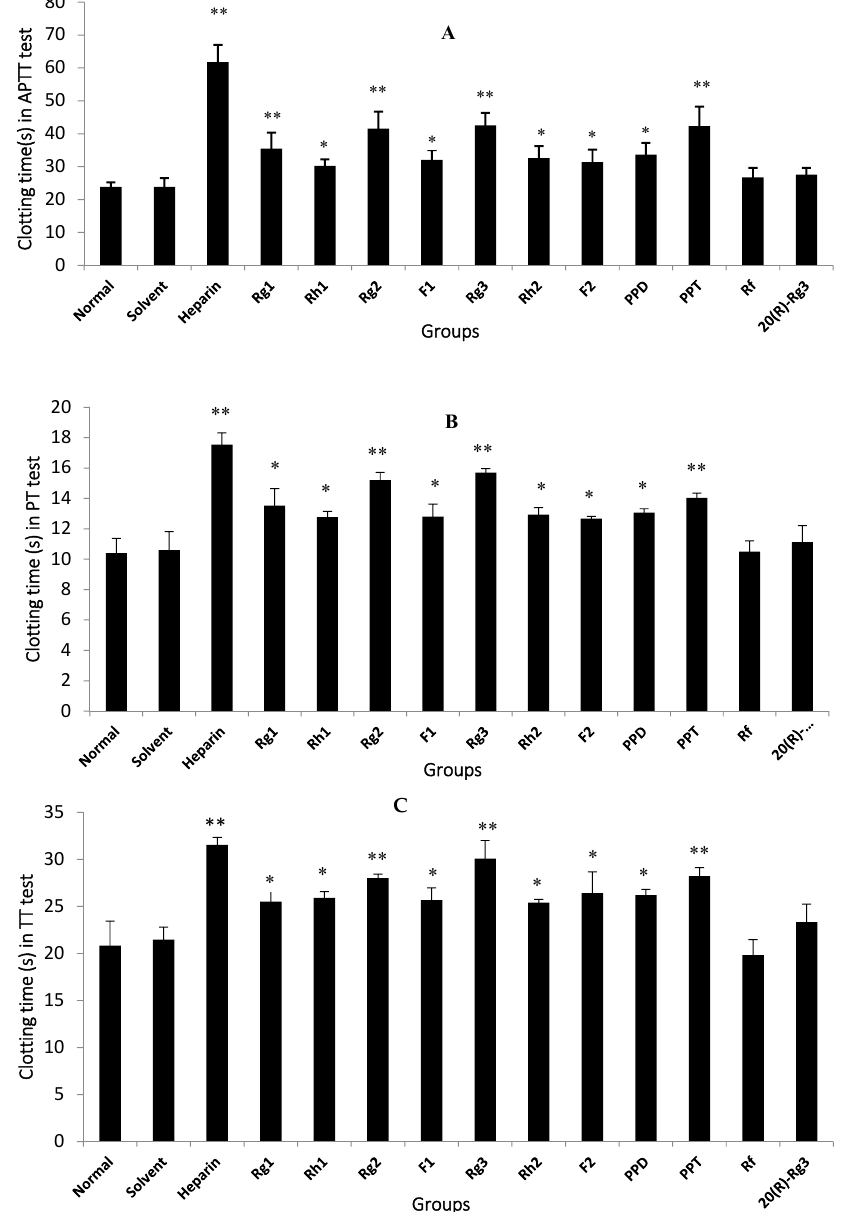
Figure 3. In vitro anti-coagulation activities of 11 ginsenosides. ( A ) APTT test; ( B ) PT test; ( C ) TT test. * p < 0.05, ** p < 0.01 versus the normal control. APTT: activated partial thromboplastin time; PT: prothrombin time; TT: thrombin time.